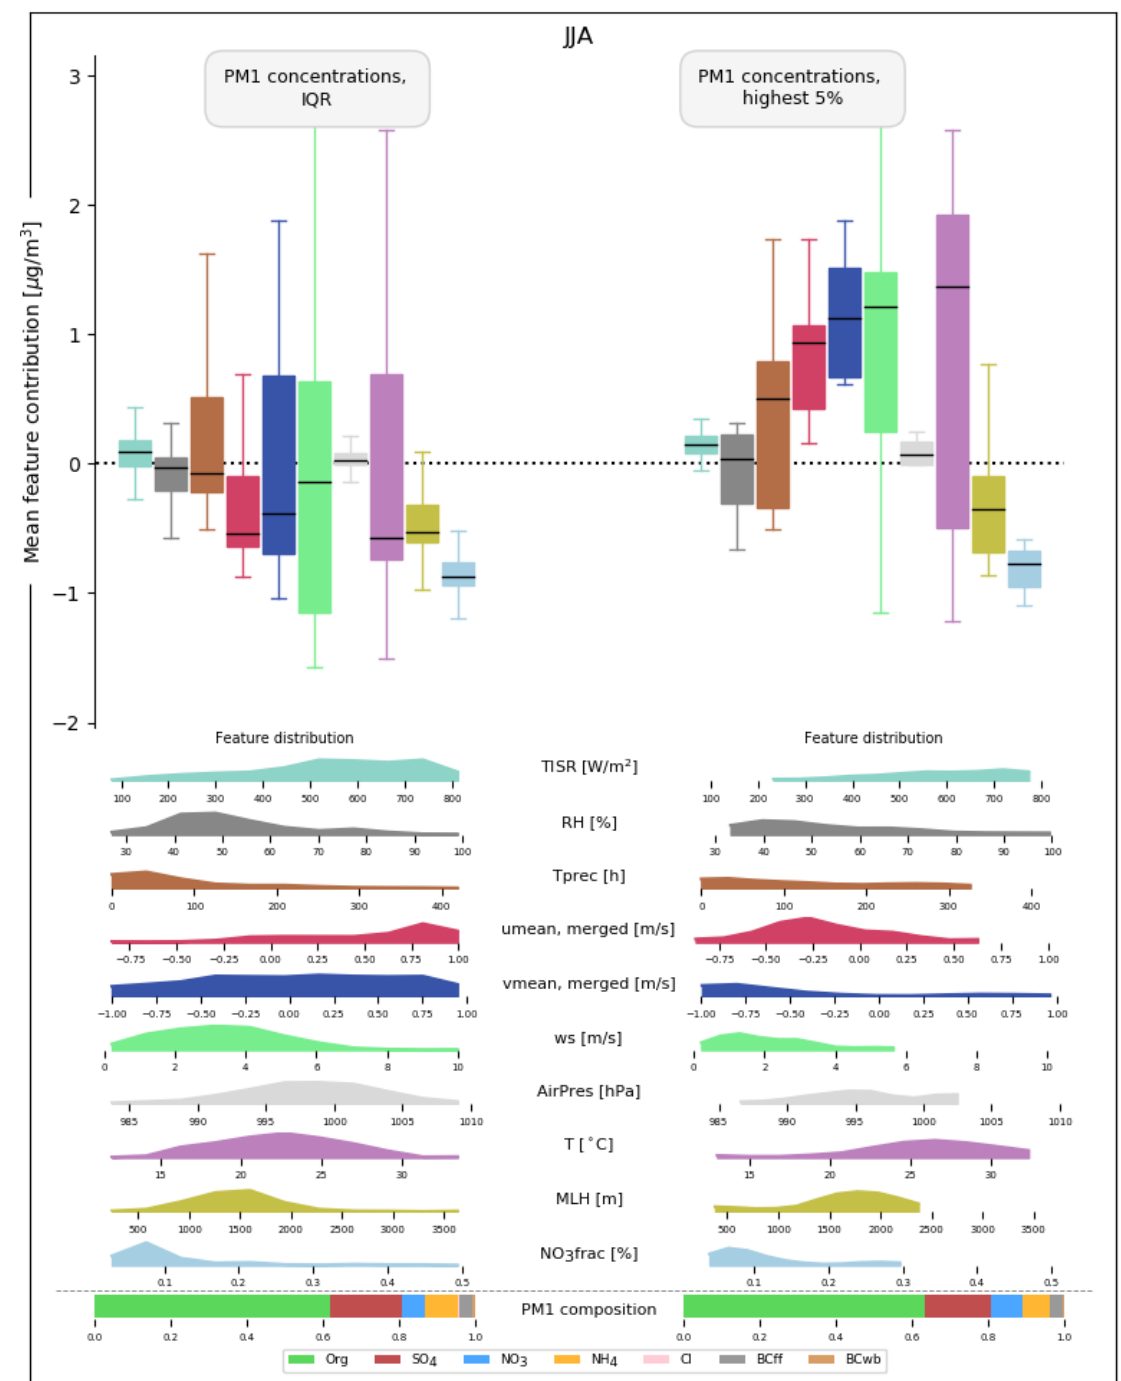
Figure 10. As Fig. 9 for mean feature contributions (i.e. SHAP values) for situations with low total PM 1 concentrations (left) and situations with high-pollution (right), respectively, during summer (July, June,